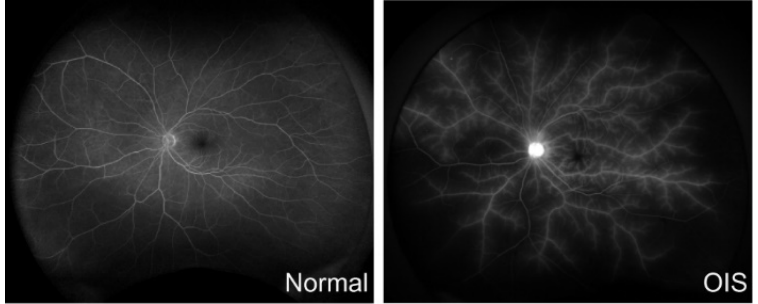
Figure 2. Fluorescein angiography (FA) in ocular ischemic syndrome (OIS). Delayed retinal circulation and hypoperfused areas are seen in OIS. There is also diffusion resembling frosted branch angiitis along all the retinal vessels. ( Left ): normal, 50 years old, 53 s; ( Right ): OIS, 79 years old, 48 s. The typical symptoms are visual loss and orbital pain [8–14]. Acute findings can be seen as ischemic transit attacks because of a transient decrease in central retinal artery blood flow. It is essential to review the patient’s history to avoid missing OIS because the duration of the attack is only a few minutes, after which vision improves. Chronic findings include capillary aneurysms, cotton-wool spots, cherry-red spots, and neovascularization at the optic disc. In addition, vitreous hemorrhage has been reported in 4% of patients